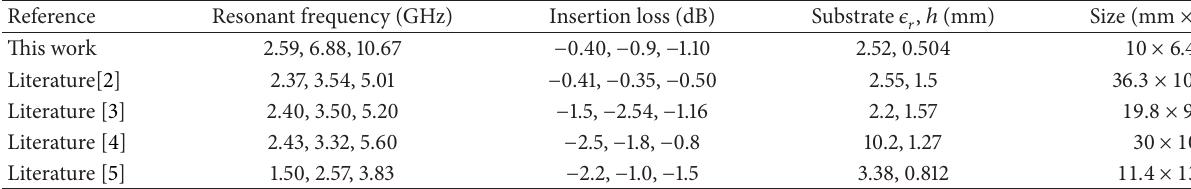
Table 3: Comparison of performance characteristics with similar BSF and BPF studies.